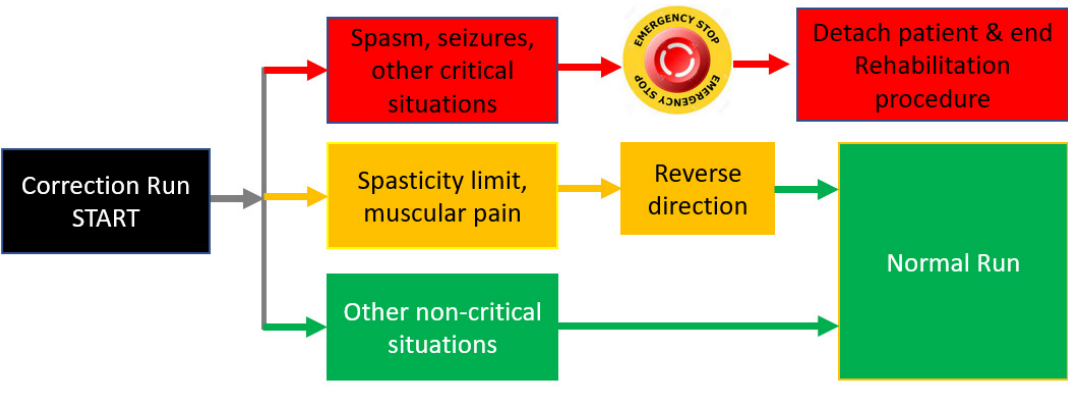
Figure 9. Actions following correction run event.